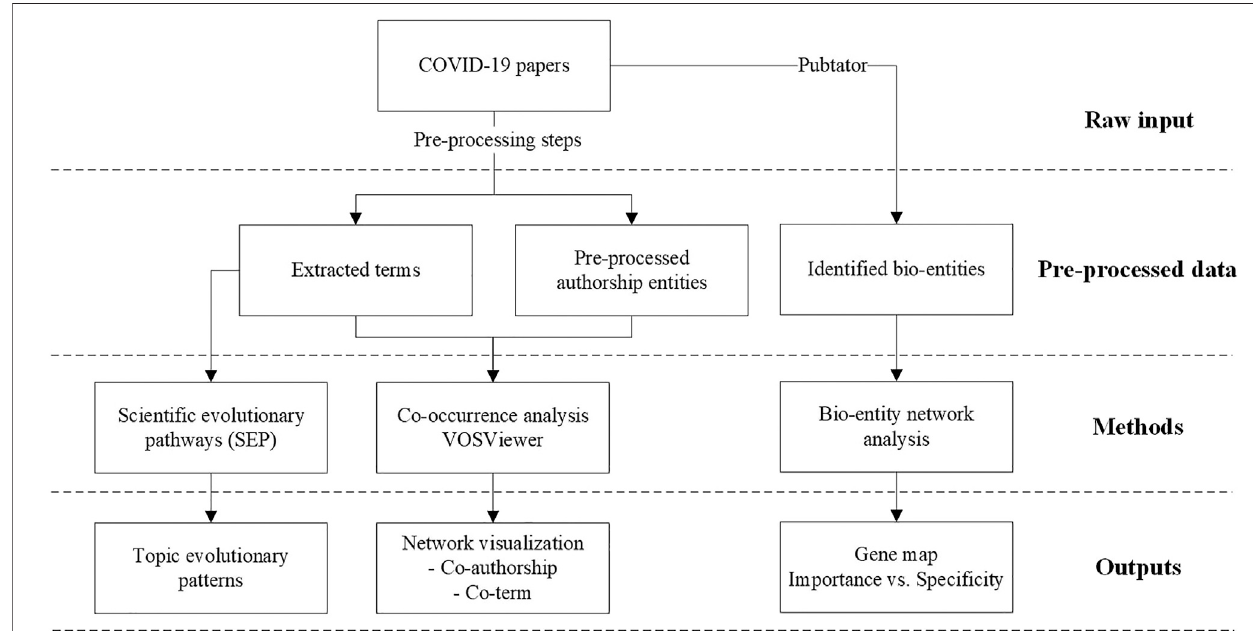
FIGURE 1 | The research